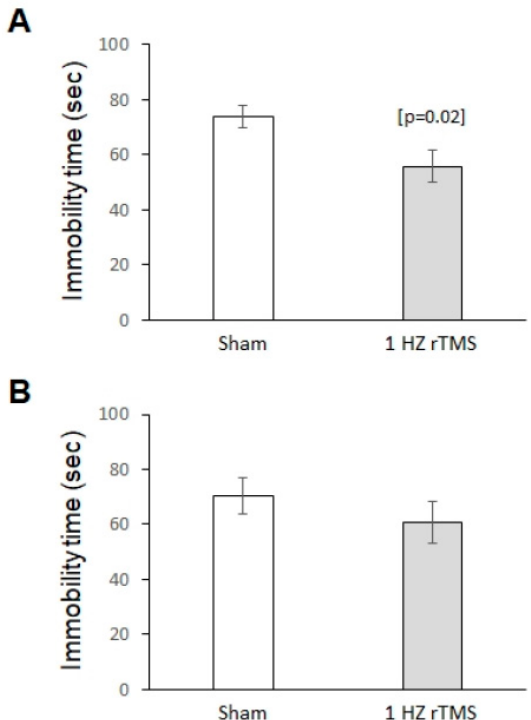
Figure 2. 1-Hz rTMS modulates depression-like behavior. ( A ) Compared with Sham-stimulated mice, 1-Hz rTMS-treated mice showed reduced depression-like behavior in the tail suspension test. ( B ) In the forced swim test, immobility time was similar between the two groups. Data are reported as mean ± SE ( n = 10 in both groups). p <